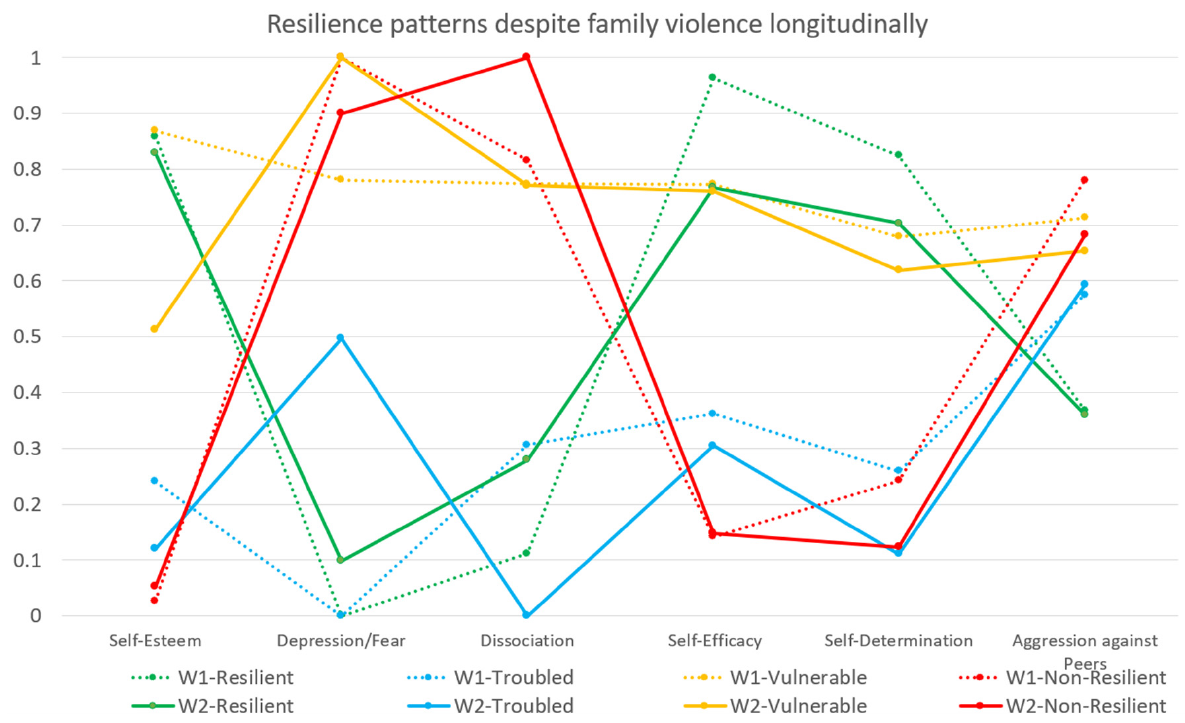
Figure 1. Item response probabilities and violence resilience-outcome patterns for both